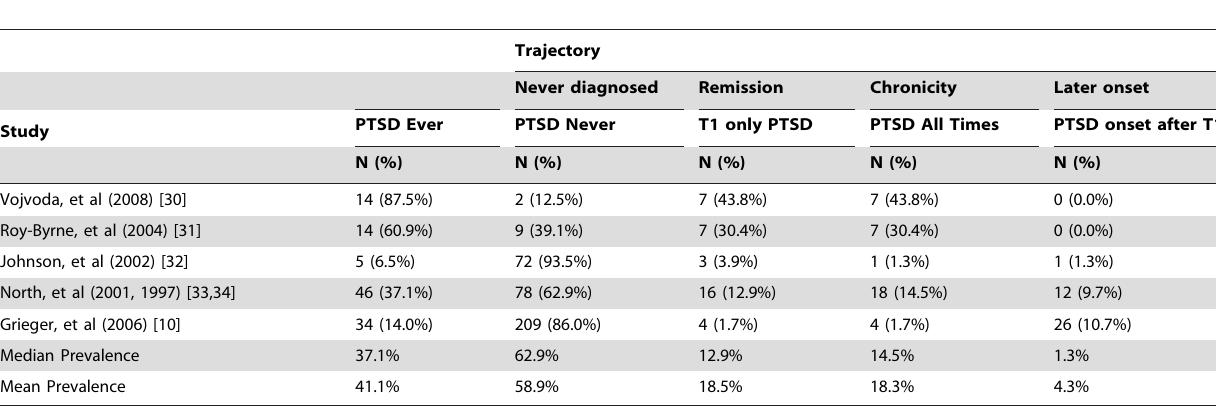
Table 2. Individual trajectories of PTSD prevalence in DSM-5-Direct Experiencing category with intentional trauma exposure (N =5 studies).